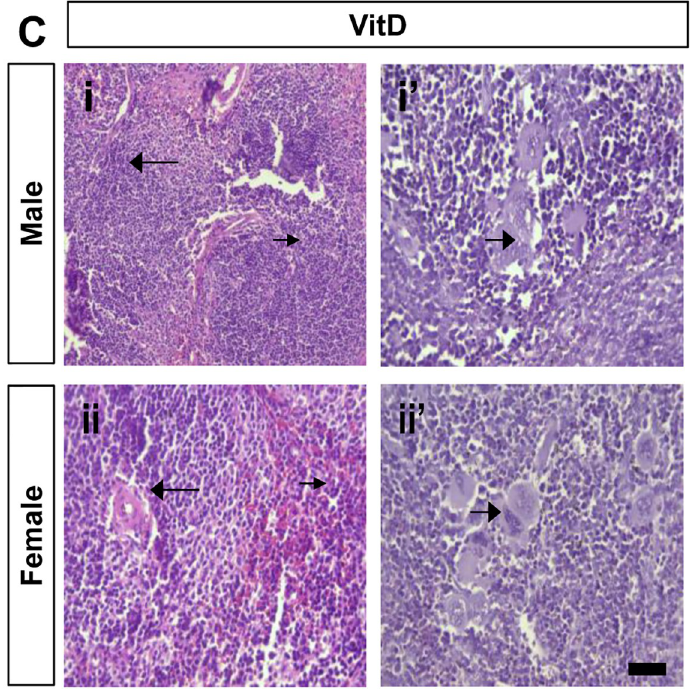
Fig 6. Histopathological analysis in hematoxylin and eosin (H&E) stained spleen of the VitD-treated mice (40 X). The splenic tissues of male and female VitD-treated mice at high (panels Ci and ii) and low (panels Ci’ and ii’) magnification exhibit a part of the reactive germinal center (long arrow) with congested sinusoids (long arrow) and a few scattered macrophages (short arrow).